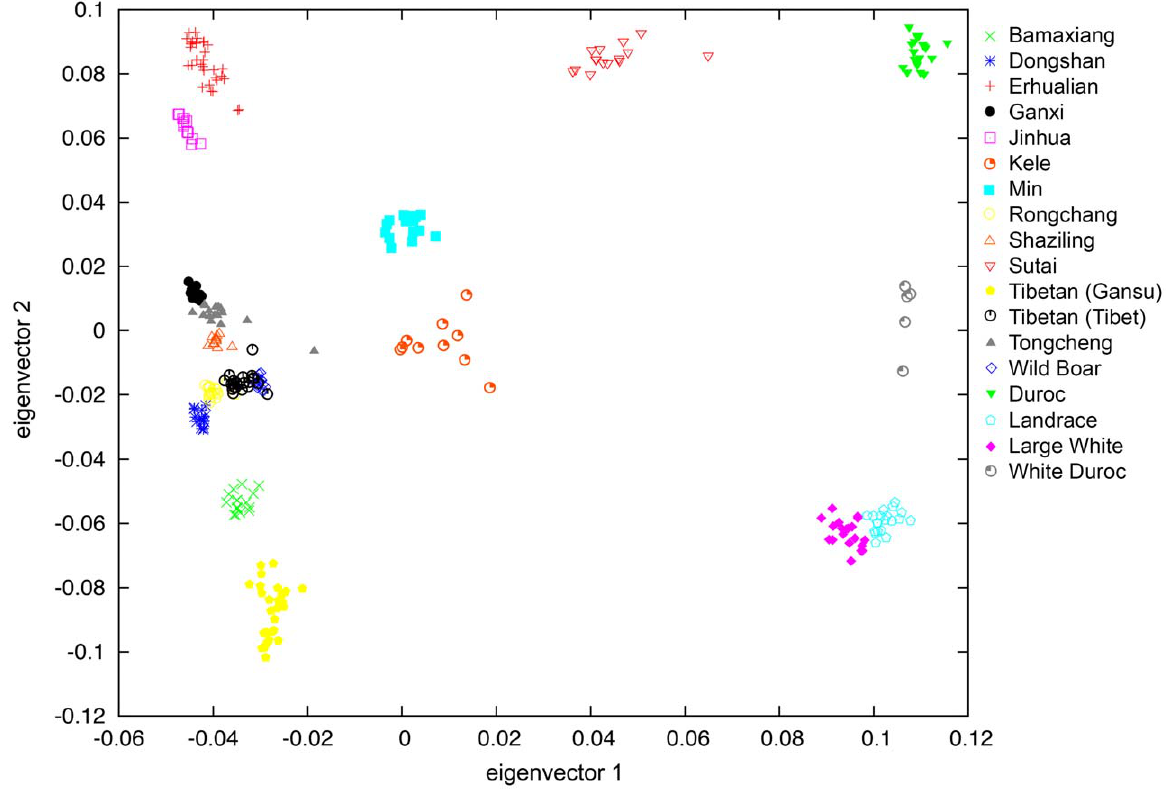
Figure 3. Population structures of Chinese and Western pigs revealed by principal component analysis.